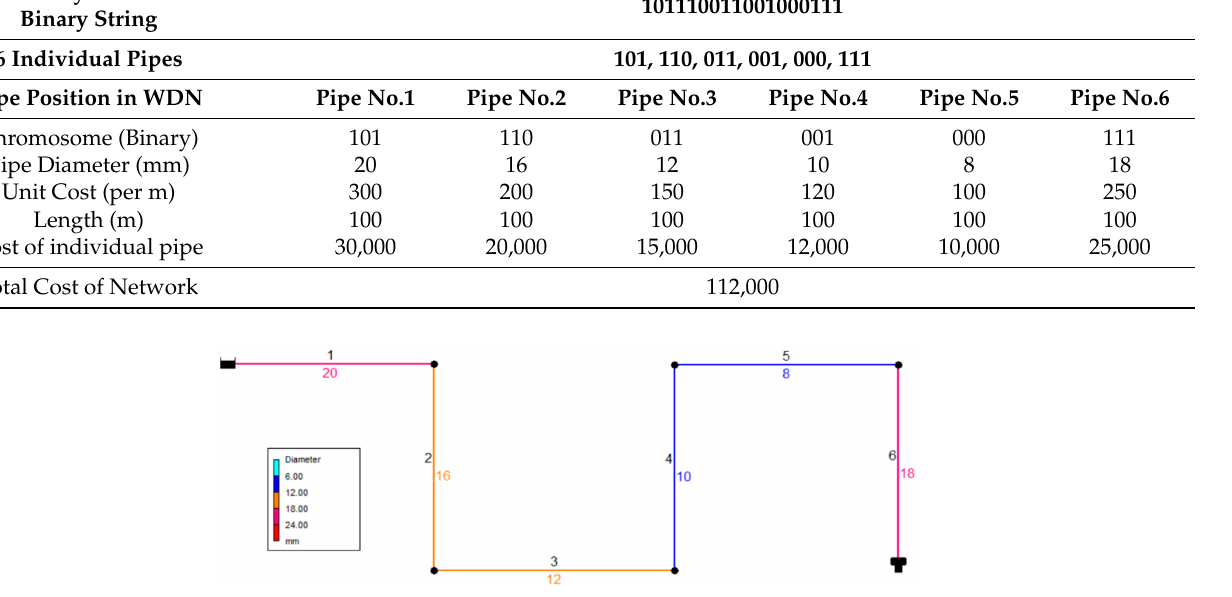
Figure 2. Example: Pipe network showing pipe position and